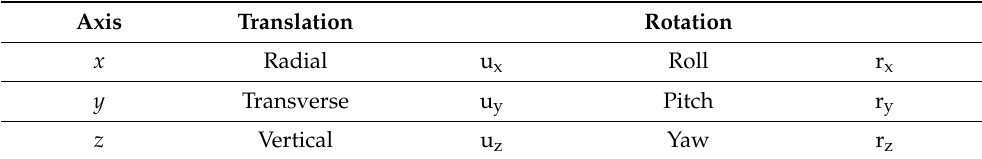
Table 1. The ground